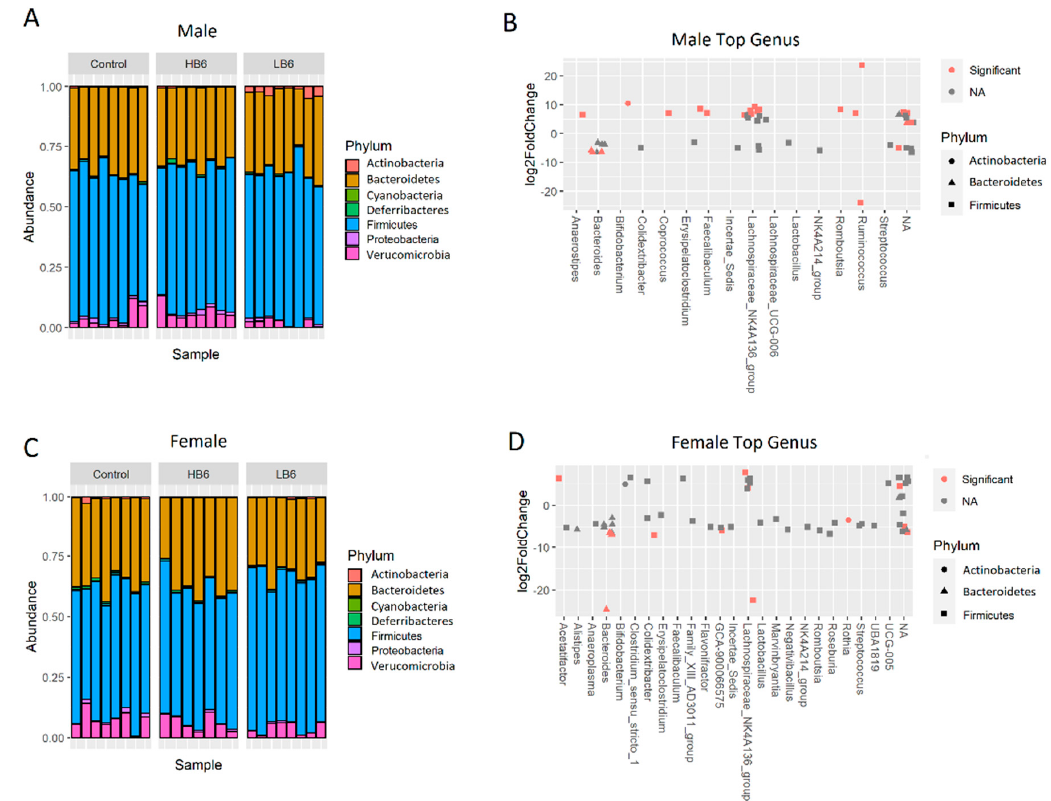
Figure 3. Relative abundance of bacterial taxa using 16S rRNA gene sequencing. Phylum level relative abundance of cecal bacteria for male ( A ) and female ( C ) rats, and the top significantly different genera between the Control and LB6 male ( B ) and female ( D ) rats with their corresponding log2Fold changes. Genera depicted in red are significant at fdr p -value < 0.05. n = 7–8/group of each sex.